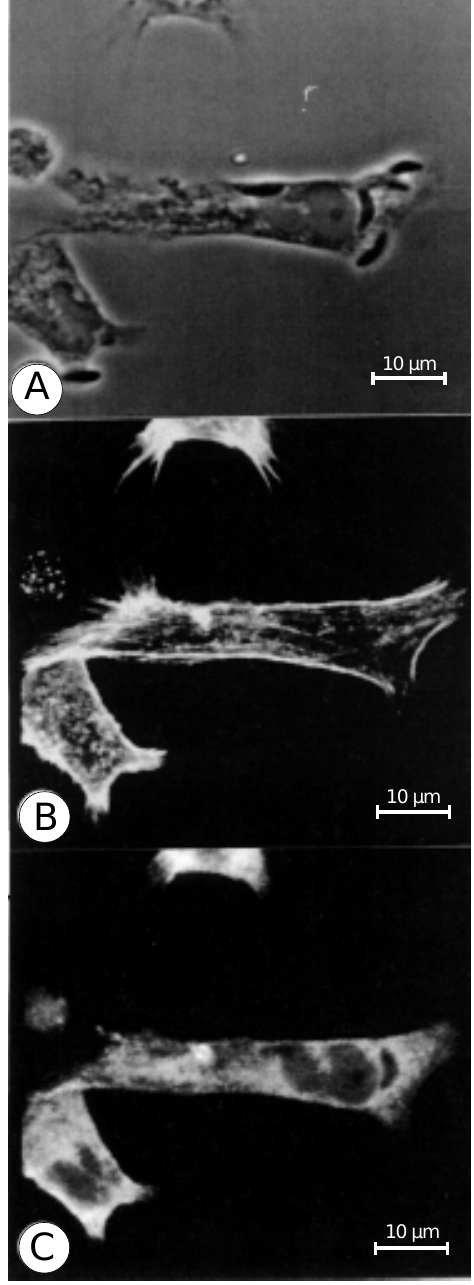
Figure 2 - Parasites allowed to interact with macrophages. A shows an image by phase con- trast microscopy. Visualization of sites of tyrosine phosphorylation (B) and actin microfilaments (C) in macrophages allowed to inter- act with tachyzoites of Toxo- plasma gondii. Bar = 10